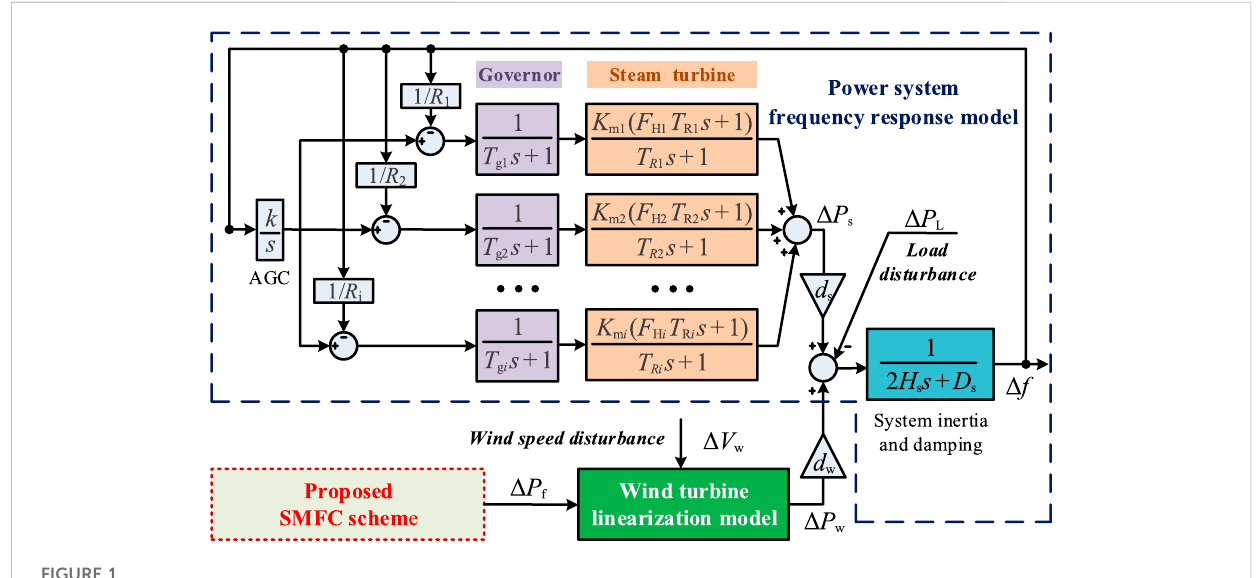
FIGURE 1 Power system frequency response model with WTs participating in FRS.